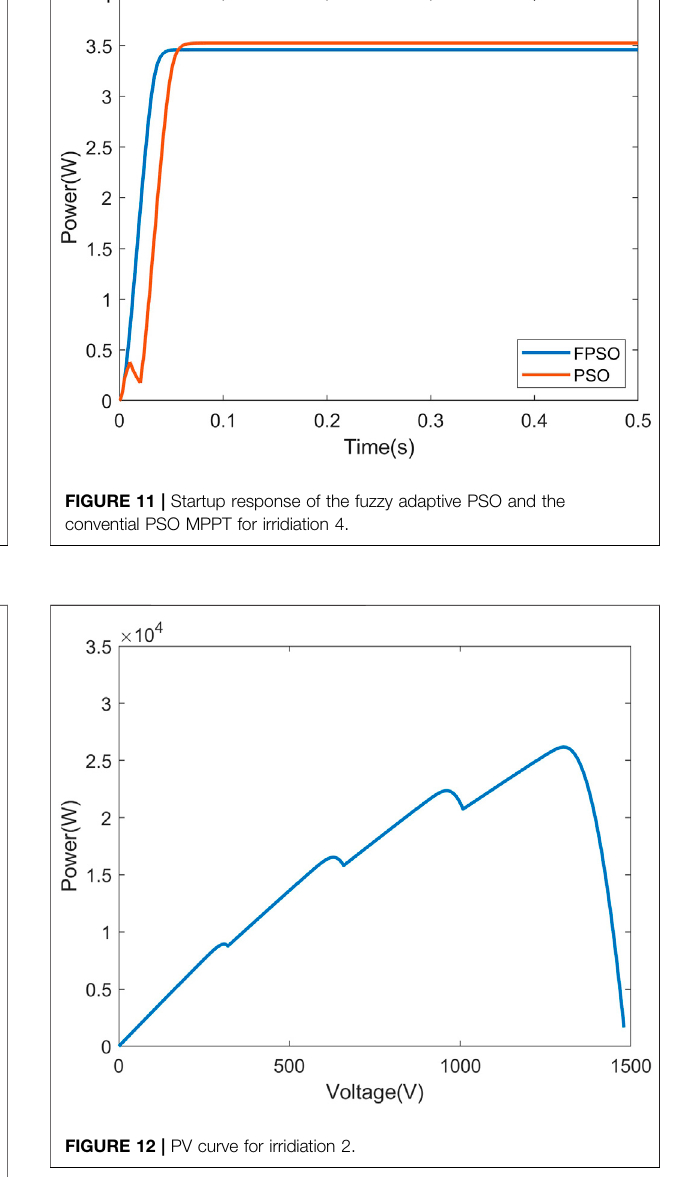
Frontiers in Energy Research |